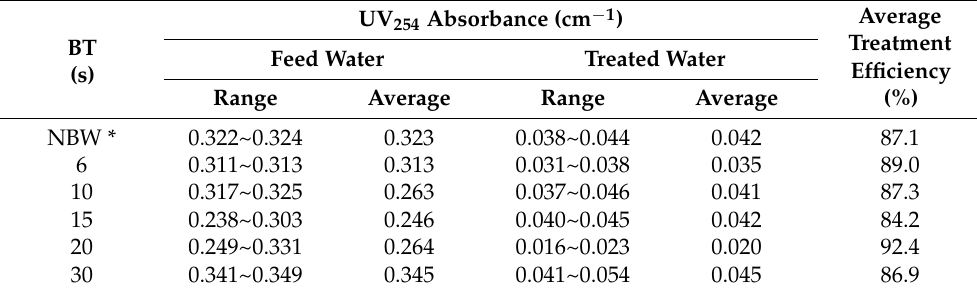
Table 4. Water quality and treatment efficiency of DOM (UV 254 absorbance) in the combined process of tubular alumina MF (NCMT-7231) and PP beads for the influence of water backwashing time. UV 254 Absorbance (cm − 1 ) Average Treatment BT (%)Feed Water Treated Water Efficiency (s) Range Average Range Average NBW * 0.322~0.324 0.323 0.038~0.044 0.042 87.1 6 0.311~0.313 0.313 0.031~0.038 0.035 89.0 0.317~0.325 0.263 0.037~0.046 0.041 87.3 15 0.238~0.303 0.246 0.040~0.045 0.042 84.2 20 0.249~0.331 0.264 0.016~0.023 0.020 92.4 30 0.341~0.349 0.345